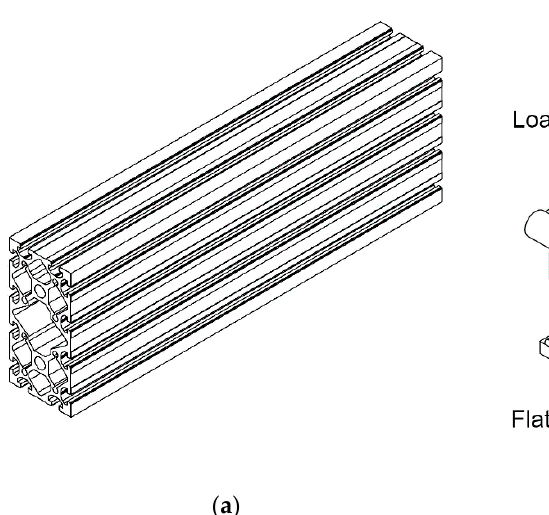
Figure 4. ( a ) Alu profile; ( b ) press element.